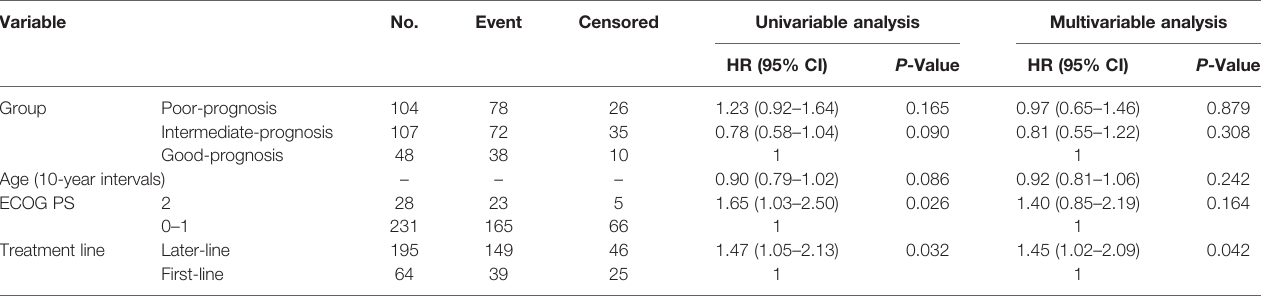
TABLE 3 | Univariable and multivariable Cox proportional hazard ratio of the prognostic score for progression-free survival. Variable No. Event Censored Univariable analysis Multivariable analysis